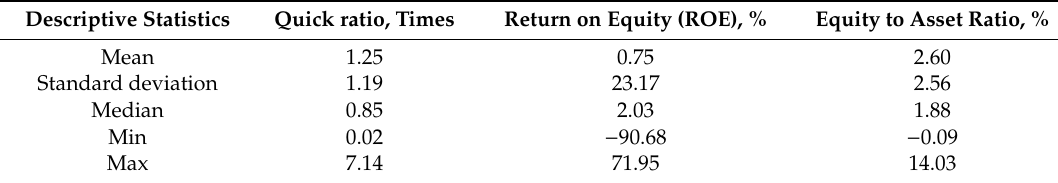
Table 6. Construction firm financial ratios: Descriptive